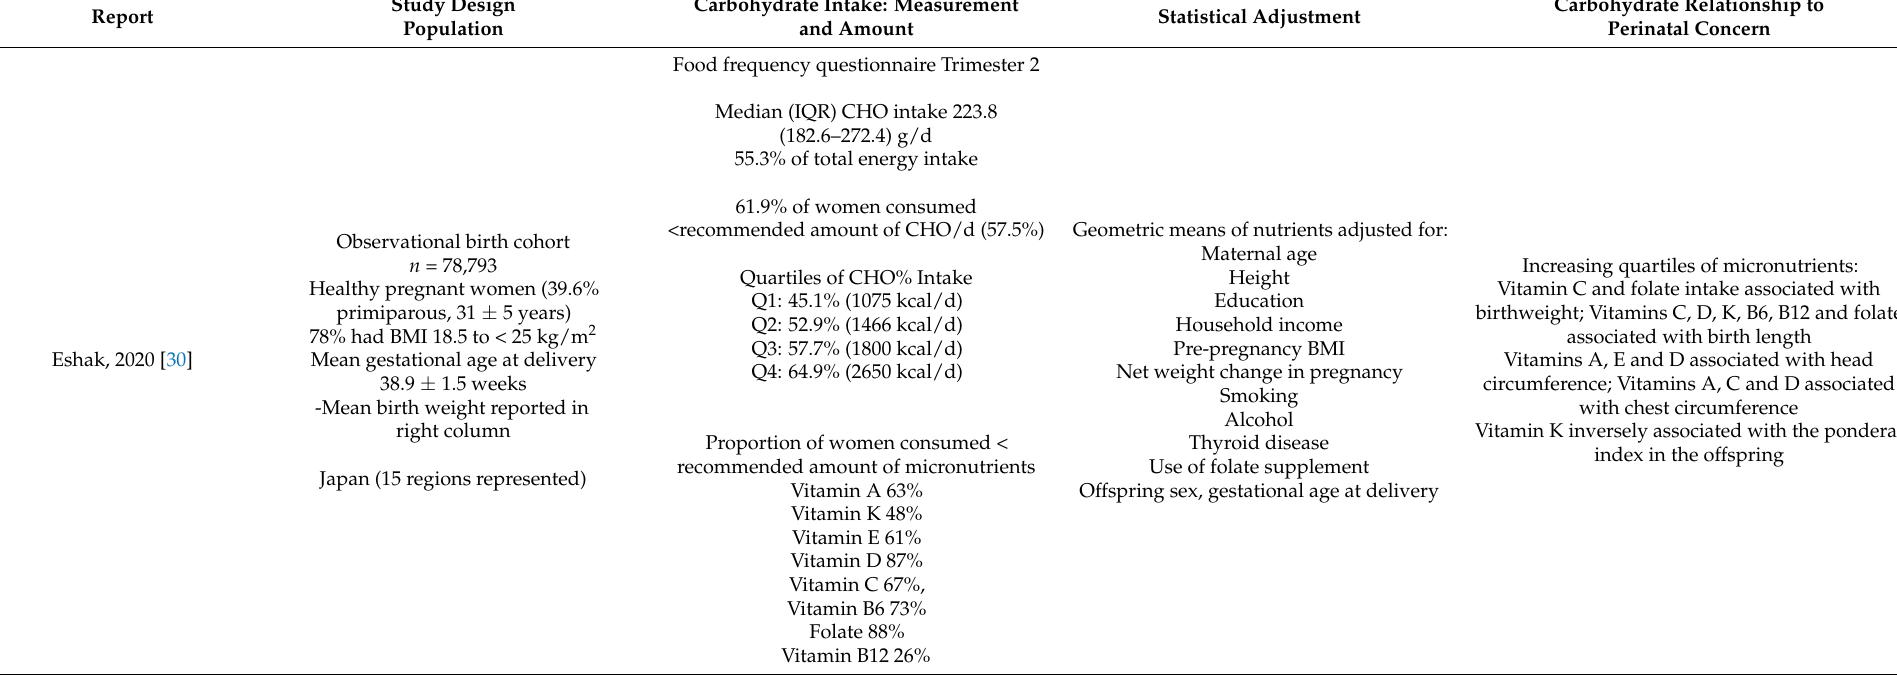
Table 3. Reports relevant to research question 3: Do pregnant women who consume a LC diet have an increased risk for micronutrient